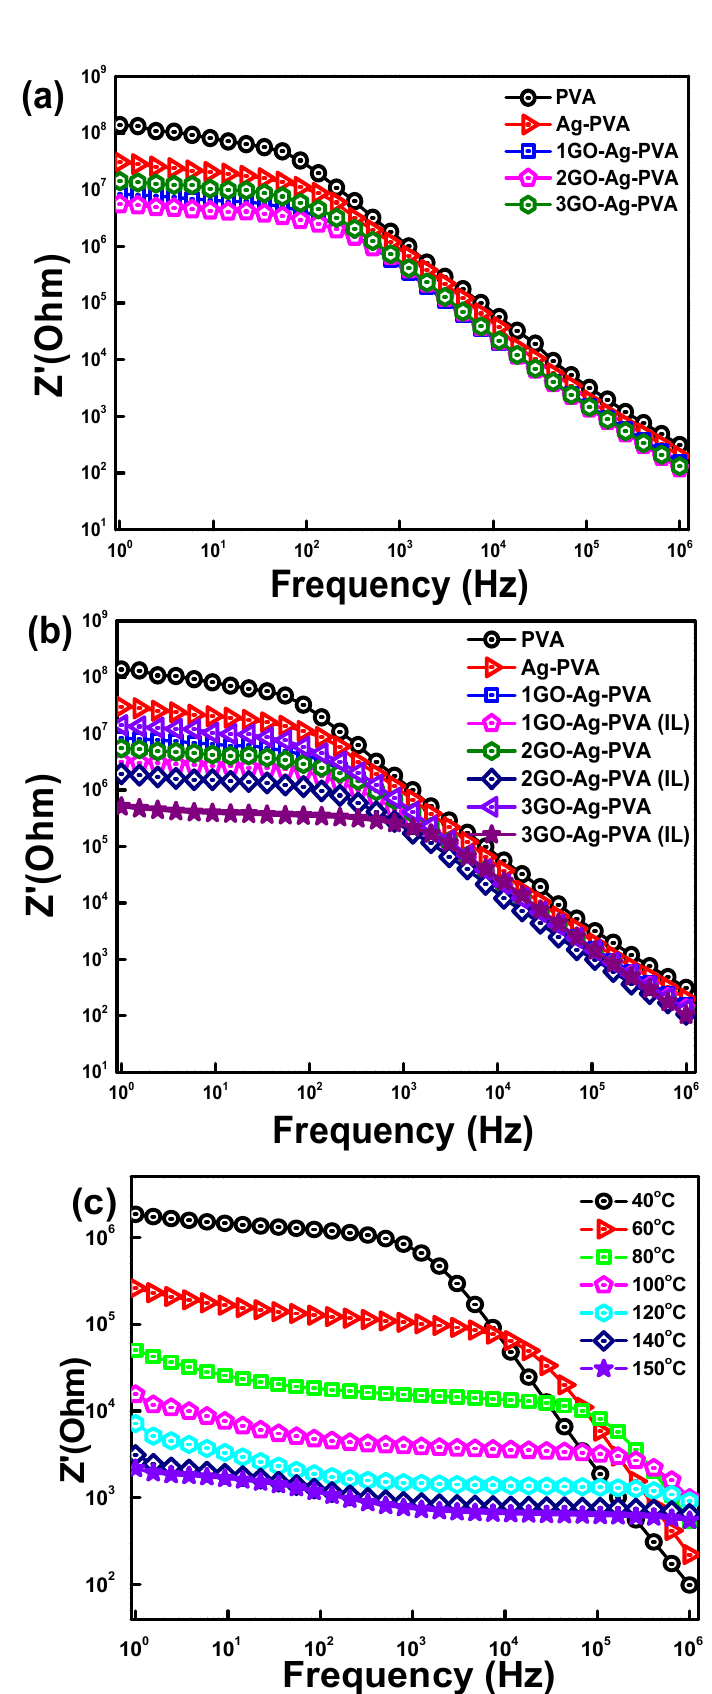
Figure 5. Real impedance of GO-Ag-PVA nanocomposites as a function of ( a ) GO loading, ( b ) ionic liquid and ( c ) temperature effect on 3GO-Ag-PVA (IL).